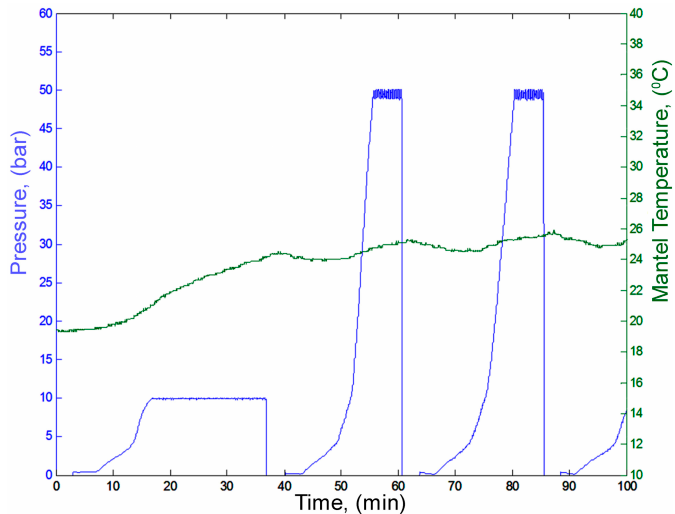
Figure 10. Pressure in the chamber and average temperature from outside chamber, batch—deionised water 350